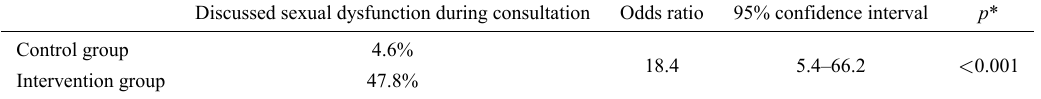
Table 2b. Comparison of primary study outcome.